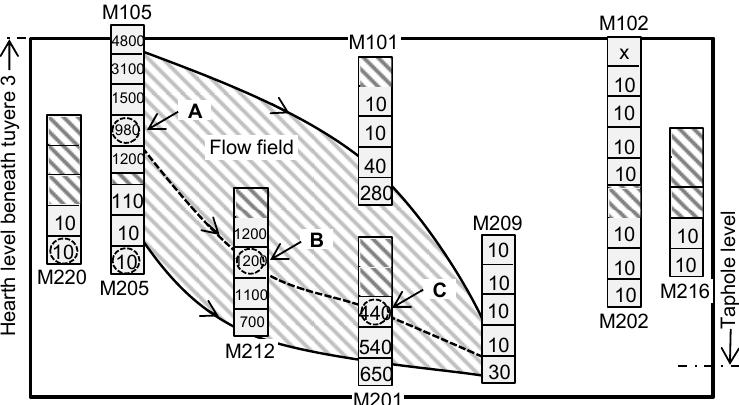
Figure 11. Interpreted flow field of the hot metal in the L-L cross section from Figure 9 (numbers in the squares indicate Cu contents in the metal samples given in ppm).